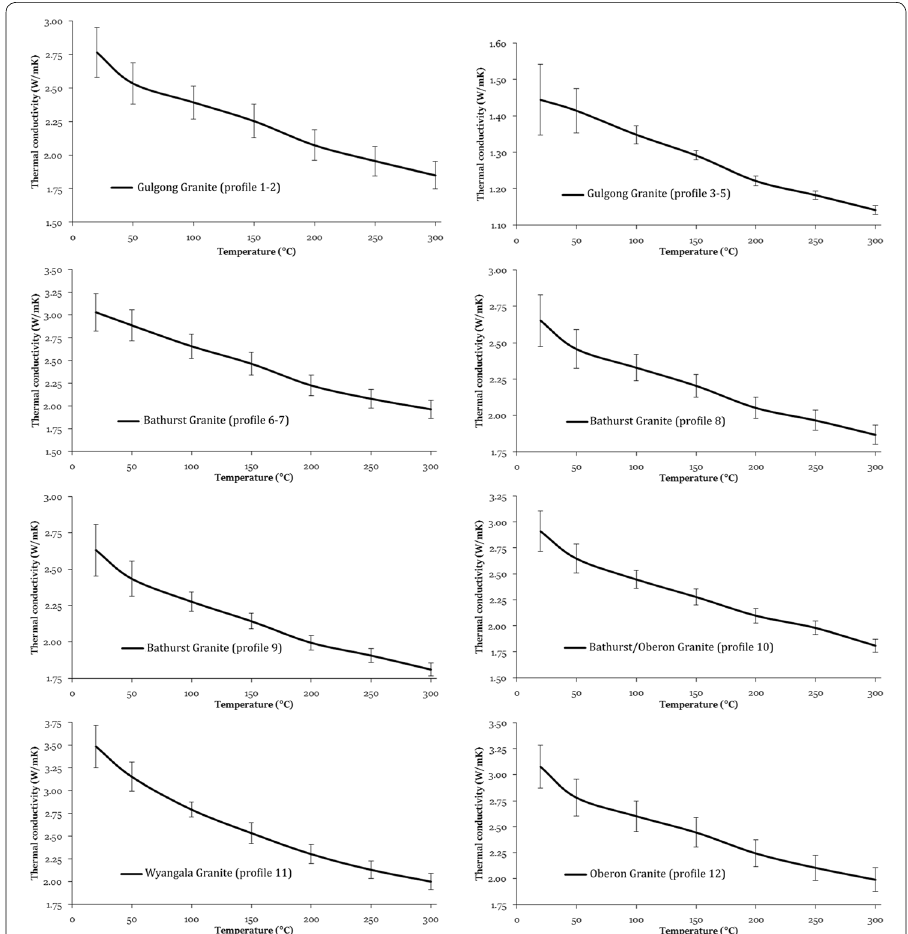
Fig. 7 Thermal conductivity measurements of basement rocks. Basement layer numbers correspond to their respective profile, layers 1–5 are composed of the Gulgong Granite, layers 6–10 are composed of the Bathurst and Oberon Granite, and layers 11–12 are composed of the Wyangala and Oberon Granite. Thermal conductivities consistently decrease at higher temperatures. Error margin remains relatively low, with higher uncertainty at lower